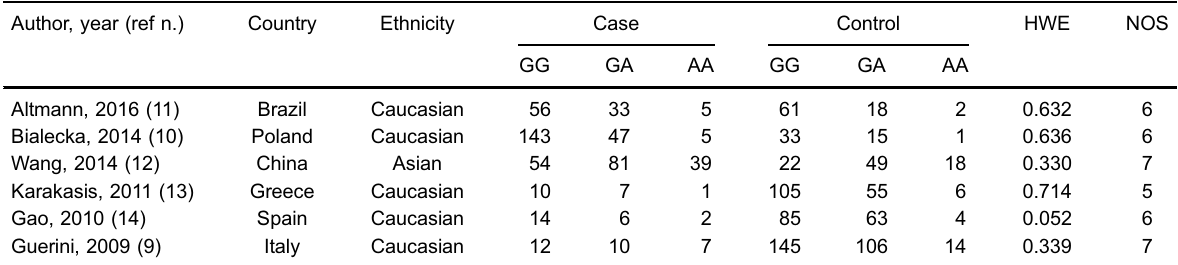
Figure 1. Selection of publications included in this Table 1. Characteristics of included studies.